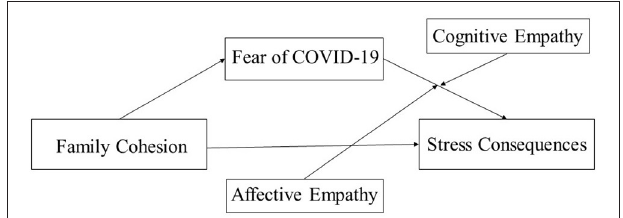
FIGURE 1 | The proposed moderated mediation model.